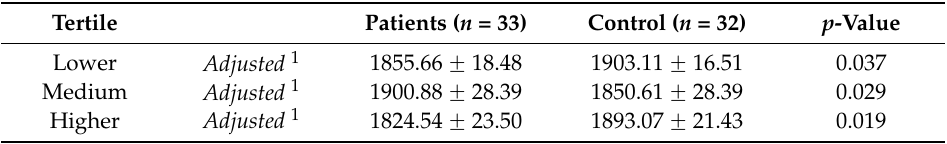
Table 7. QUS figures based in the vitamin D intake tertile and between